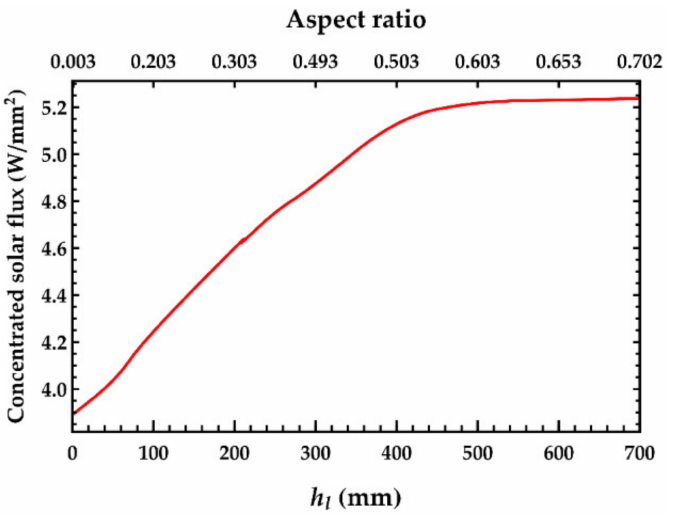
Figure 13. Concentrated solar flux of the ESFL with a combined h f + h d of 700 mm as a function of h l and aspect